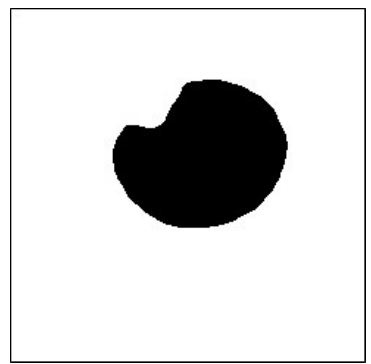
Figure 32. Multithreshold pupil image.